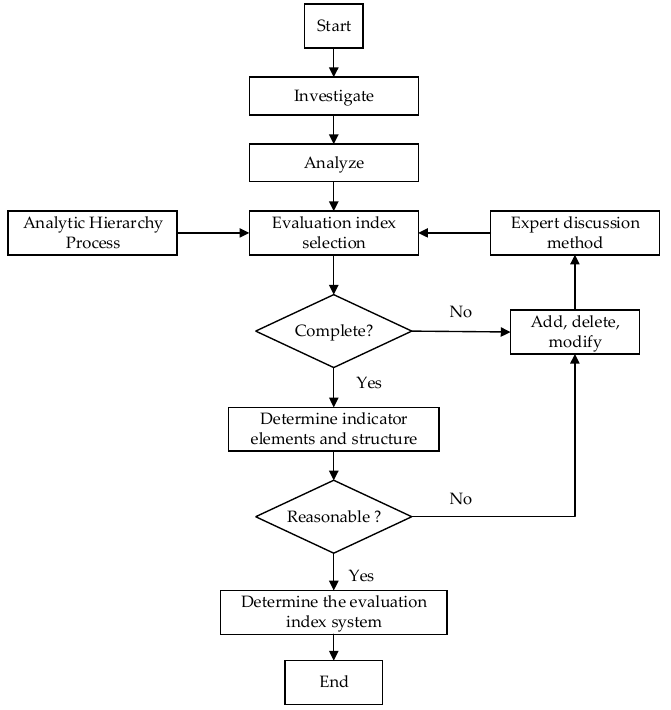
Figure 1. Determine the process of evaluating the technical indicator system.